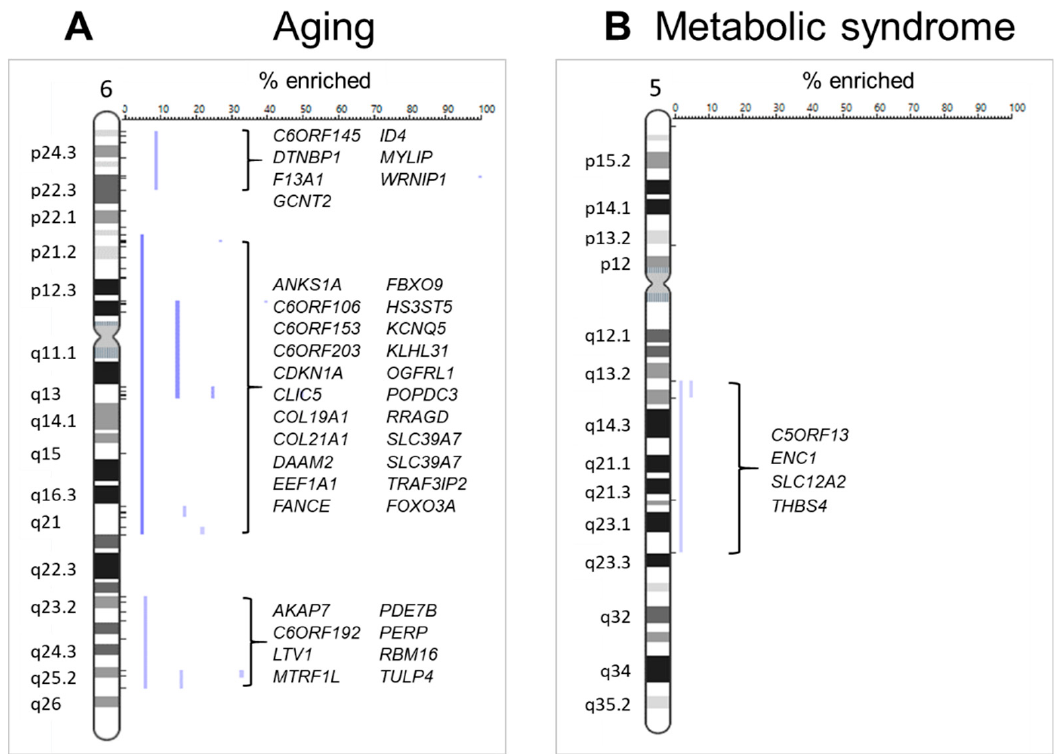
Figure 2. Enriched chromosomal regions. ( A ) Three major regions of chromosome 6 (p24, p21–q21, q23–q25) were significantly enriched in genes differentially expressed with healthy aging. ( B ) One region of chromosome 5 (q13–q23) was significantly enriched in genes differentially expressed with metabolic syndrome in muscle of old men. Blue lines indicate each enriched loci, and the genes associated with the enriched loci are listed for chromosome 5 and 6.